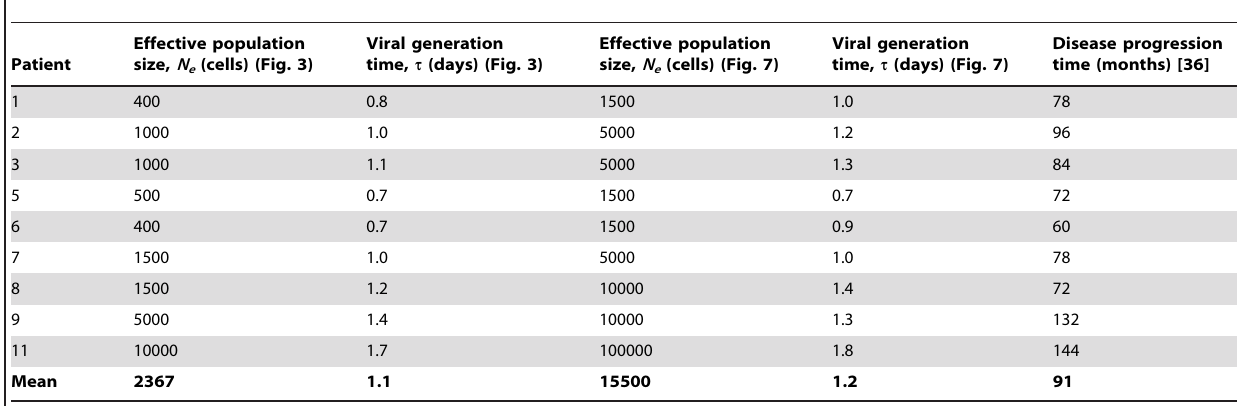
Table 1. Best-fit parameter estimates and the disease progression time.